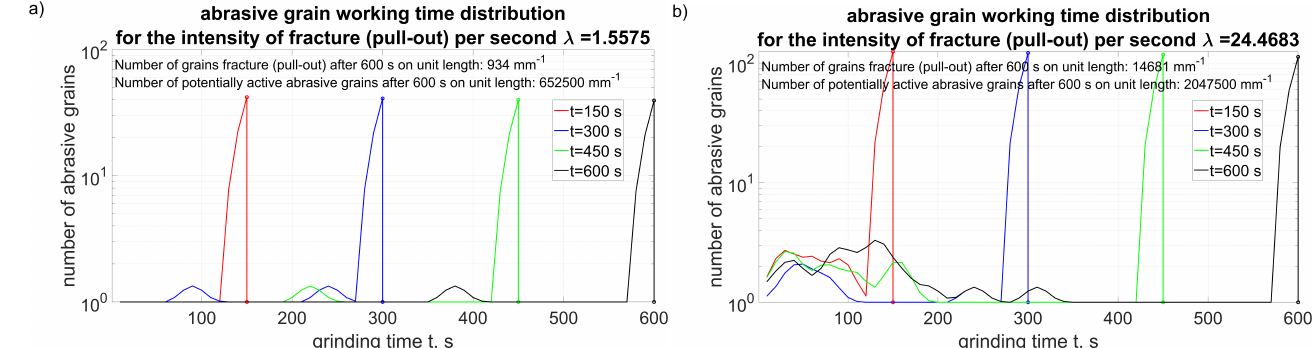
Figure 13. Abrasive grain working time distributions (Equation (24)) for variable intensity of fractur- ing: ( a ) low intensity λ = 1.56, ( b ) high intensity λ =